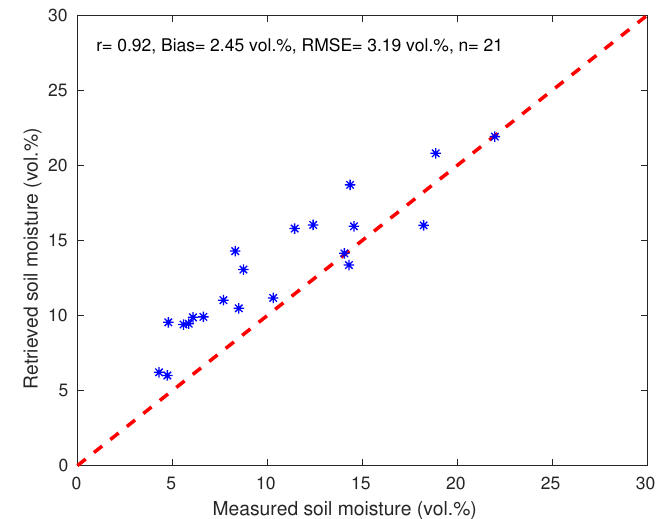
Figure 7. Comparison between retrieved soil moisture using Oh model and ground-truth